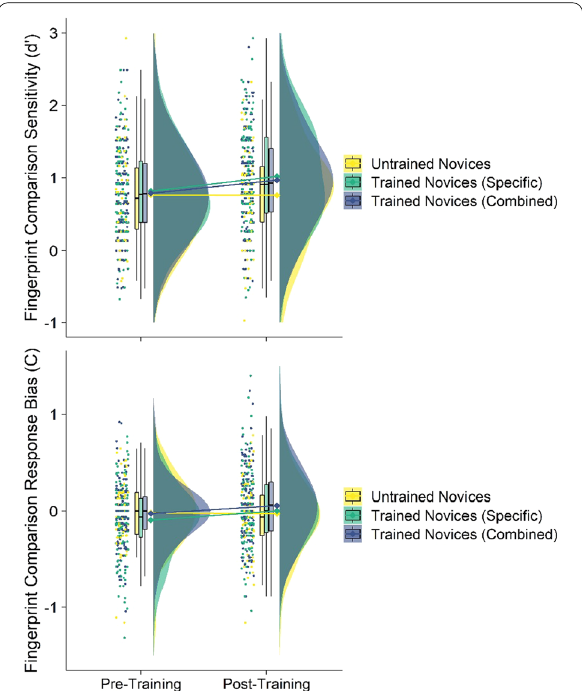
Fig. 6 Sensitivity (upper panel) and response bias (lower panel) in the fingerprint comparison task by time and condition in Experiment 2. Raincloud plots depict (left-to-right) the jittered participants’ averaged data points, box-and-whisker plots, means (represented by diamonds) with error bars representing